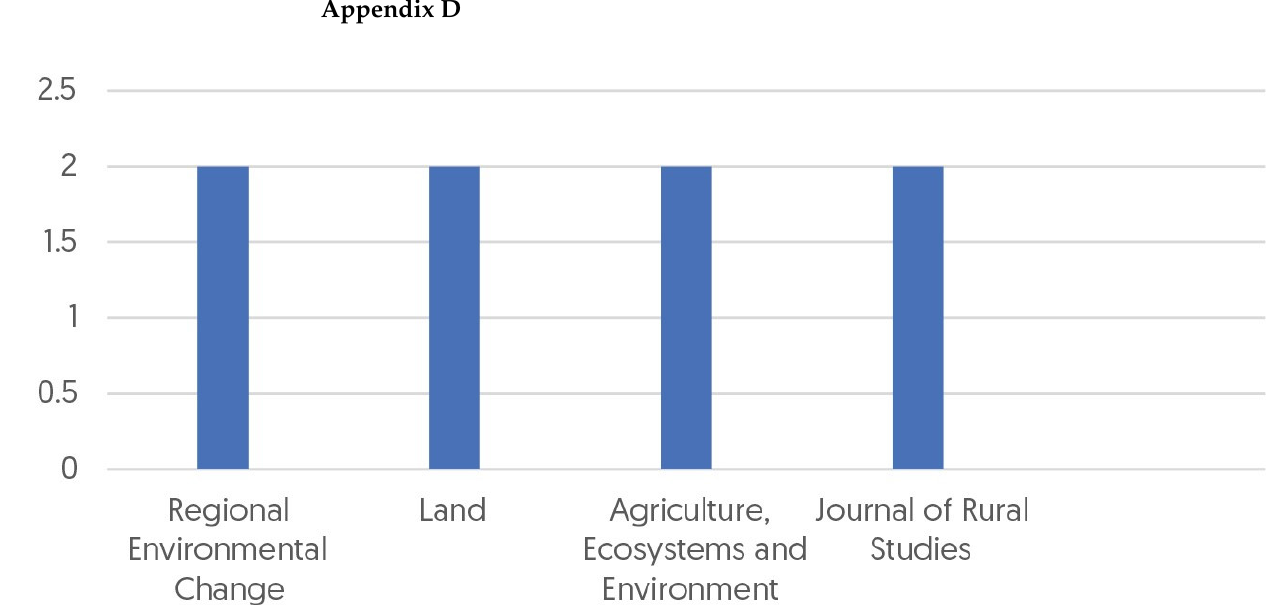
Figure A3. Four most-represented journals from systematic search.